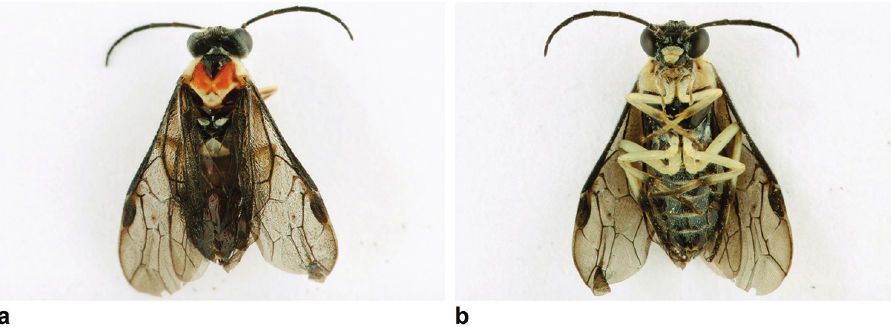
Figure 21. Stromboceros suppar , female (P4238.C), body length 7.5 mm. a Dorsal view b ventral view.